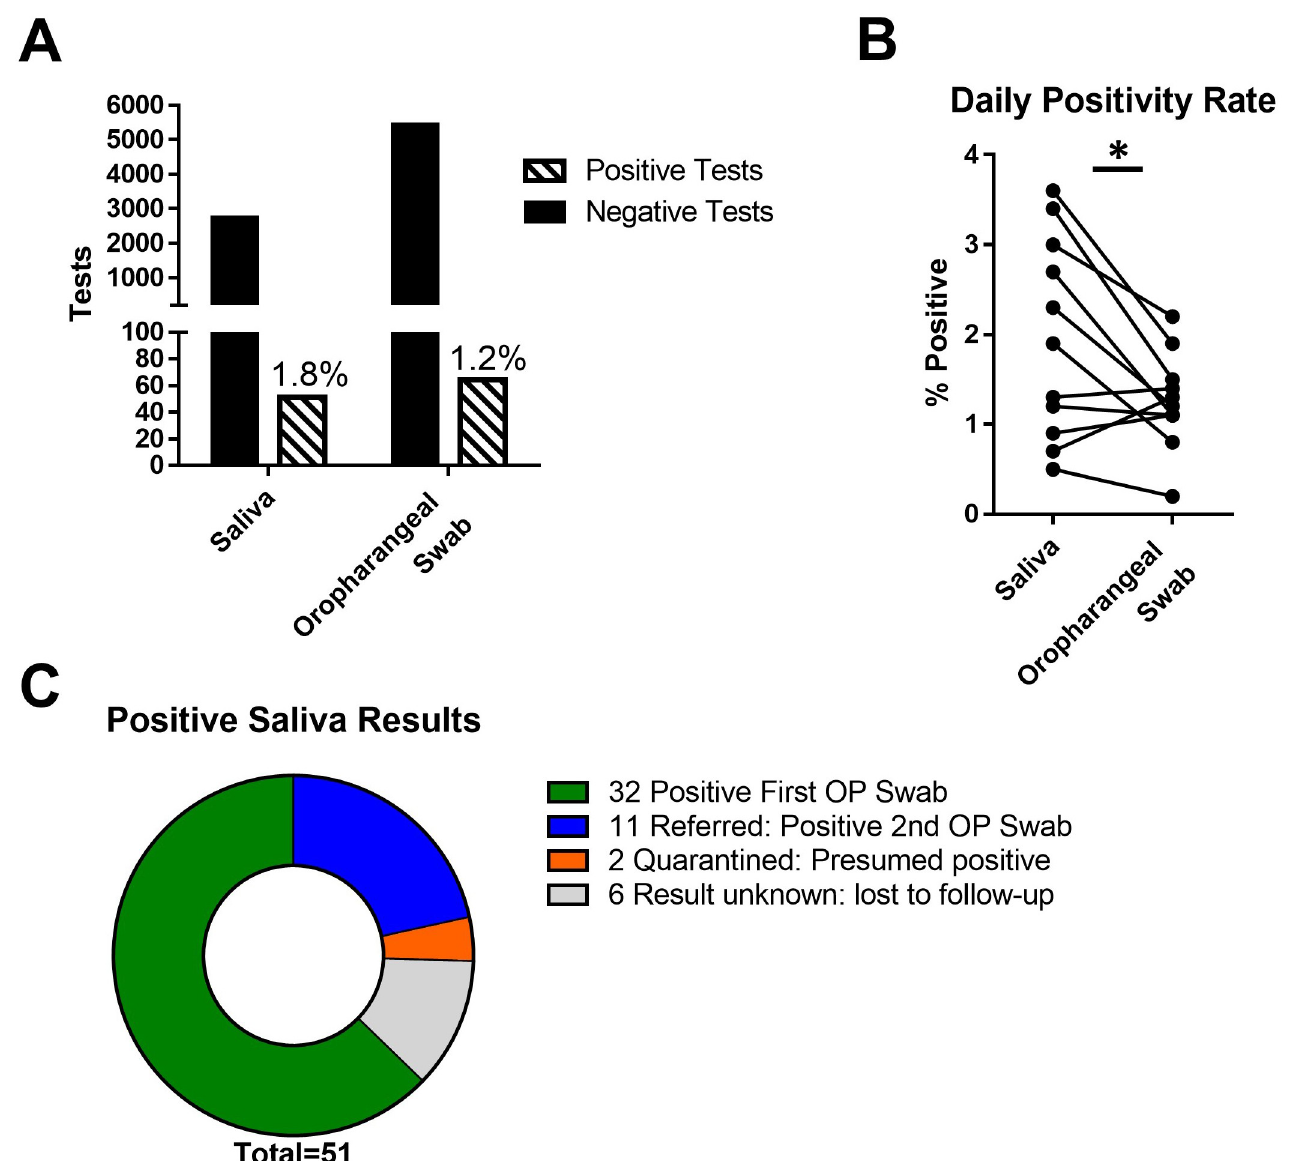
Fig 1. Validation of direct RT-PCR on pooled saliva for COVID-19 surveillance. A) RT-PCR positivity rates of diagnostic oropharyngeal swabs from asymptomatic participants in surveillance testing compared with pooled saliva samples collected at the same time from volunteers within the participant pool. B) Pairwise analysis of daily positivity rates between pooled saliva and oropharyngeal swab. � p < 0.05. C) Summary of saliva positive results at initial sample acquisition or post-referral retest of saliva positive/swab negative